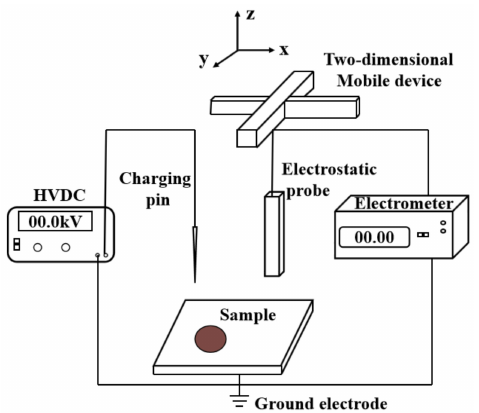
Figure 2. Experimental platform for charge dissipation.